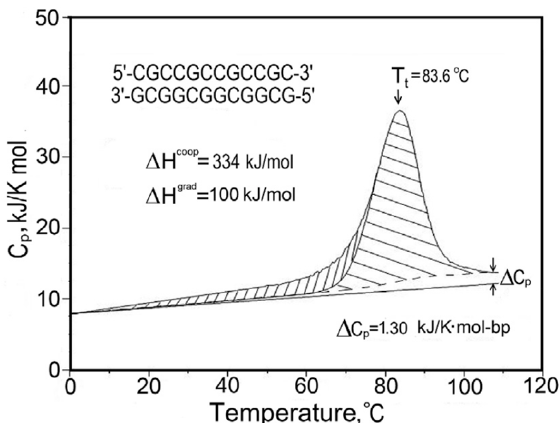
Figure 3. Observed heat capacity profile of a 12 bp all-CG duplex. The background (solid line) represents the expected heat capacity of the fully folded DNA duplex. The experimental excess heat effect is then deconvoluted into its non-cooperative (gradual, vertical hatching) and cooperative (horizontal hatching) phases. Strand separation takes place in the cooperative phase.